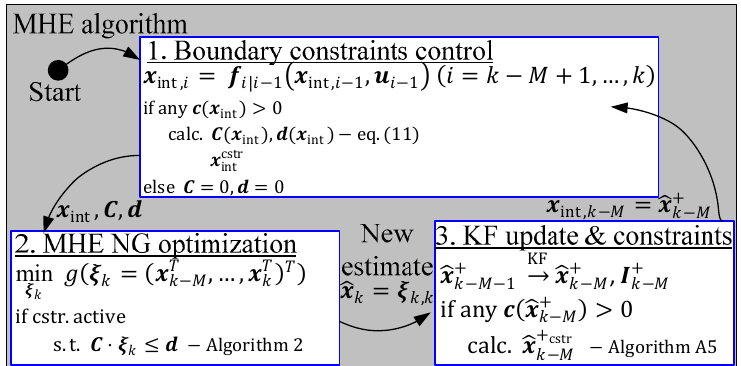
Figure 11. Flowchart of the extended moving horizon estimator.